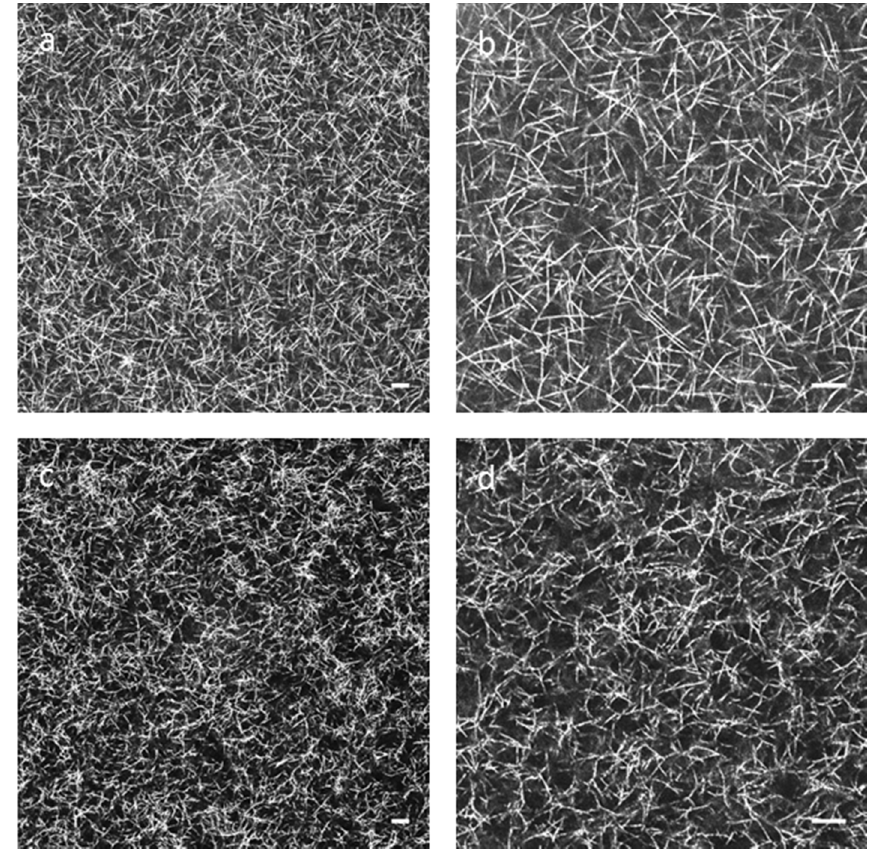
Figure 3. 3D network of the hydrogels. The confocal reflection images show the arrangement of the fibrillar networks for ( a , b ) fibrin and ( c , d ) collagen gels. ( a ) and ( c ) show a general view; ( b ) and ( d ) are zoomed images of the right-bottom corner of the previous images, respectively. Fibers composing the collagen networks are twisted, whereas the fibers in the fibrin appear straighter. Scale bars correspond to 10 μ m.